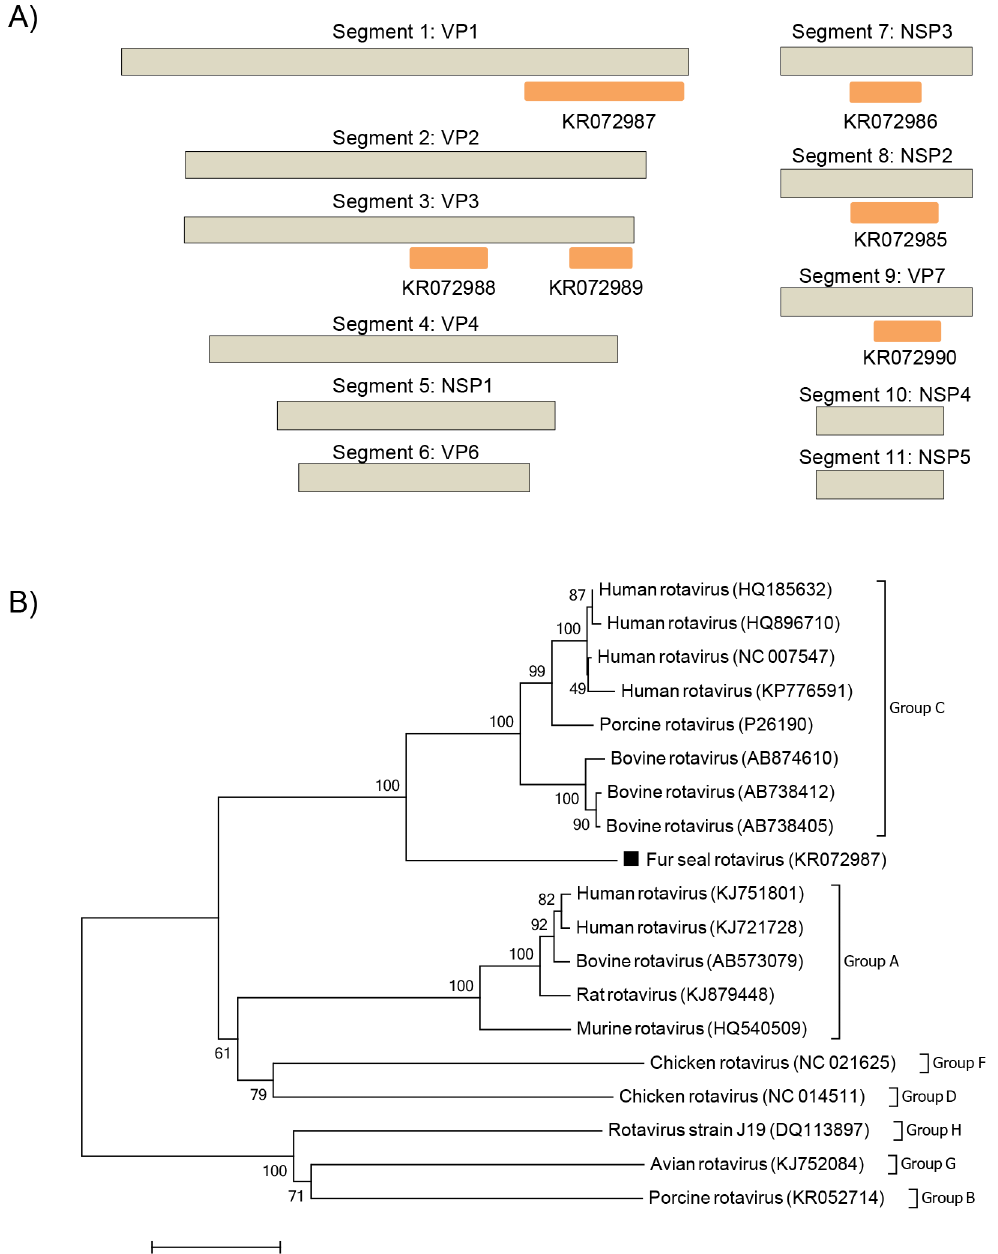
Fig 8. Phylogenetic analysis of fur seal rotavirus. (A) Schematic representation of the genome of rotaviruses using as an example the group C rotavirus (~17.9 kb). The orange bars represent the contigs from Subantarctic fur seal. (B) Neighbor-joining phylogenetic tree based on the alignment of partial amino acid sequences (307 aa) from the RpRd (segment 1) of 19 rotaviruses. Sequences of groups B, G and H were used as outgroup. The rotavirus sequence from Subantarctic fur seal identified in this study is labeled with a black square. The GenBank accession numbers of the viral sequences are shown in